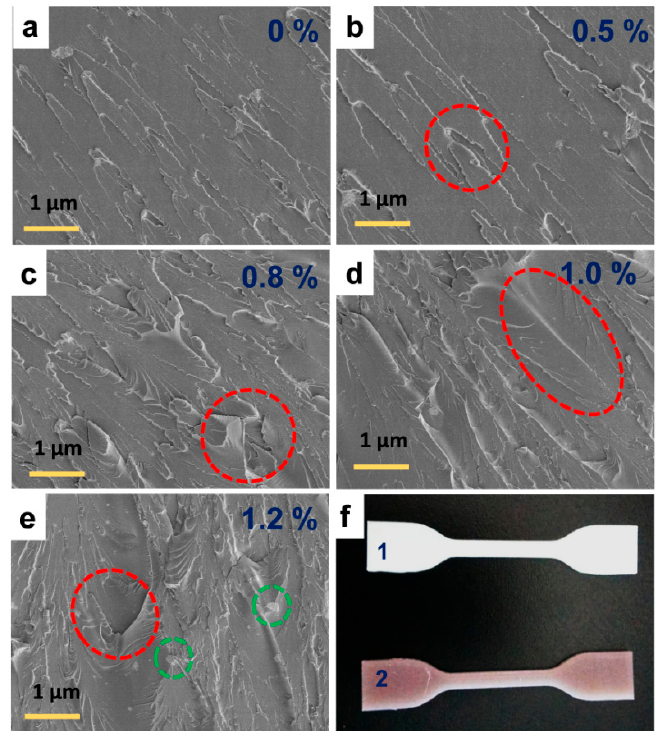
Figure 7. FESEM fracture surface analysis of tensile tested dog-bone specimens of SLA 3D printed samples: ( a ) neat SLR (smooth and less fissure surface), ( b ) SLR / Ag-TNP-0.5, ( c ) SLR / Ag-TNP-0.8 (the samples: ( a ) neat SLR (smooth and less fissure surface), ( b ) SLR/Ag-TNP-0.5, ( c ) SLR/Ag-TNP-0.8 (the marked redline circles represents the uneven cracks), ( d ) SLR / Ag-TNP-1.0 (the highlighted marked redline circles represents the uneven cracks), ( d ) SLR/Ag-TNP-1.0 (the highlighted redline demonstrates the uniform dispersion and high rough surface), ( e ) SLR/Ag-TNP-1.2 (the highlighted redline circles shows high roughness and the marked green area representing the possible agglomeration of incorporated Ag-TNP nanoparticles), ( f ) the digital photography of 3D printed dog- bone shaped SLA model samples for tensile strength before analysis ( 1 ) neat SLR and ( 2 ) SLR/Ag- TNP-1.0 sample.